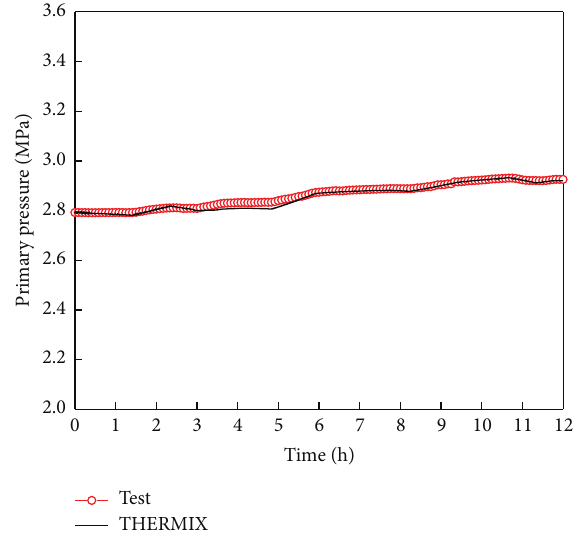
Figure 8: Helium pressure during the test.